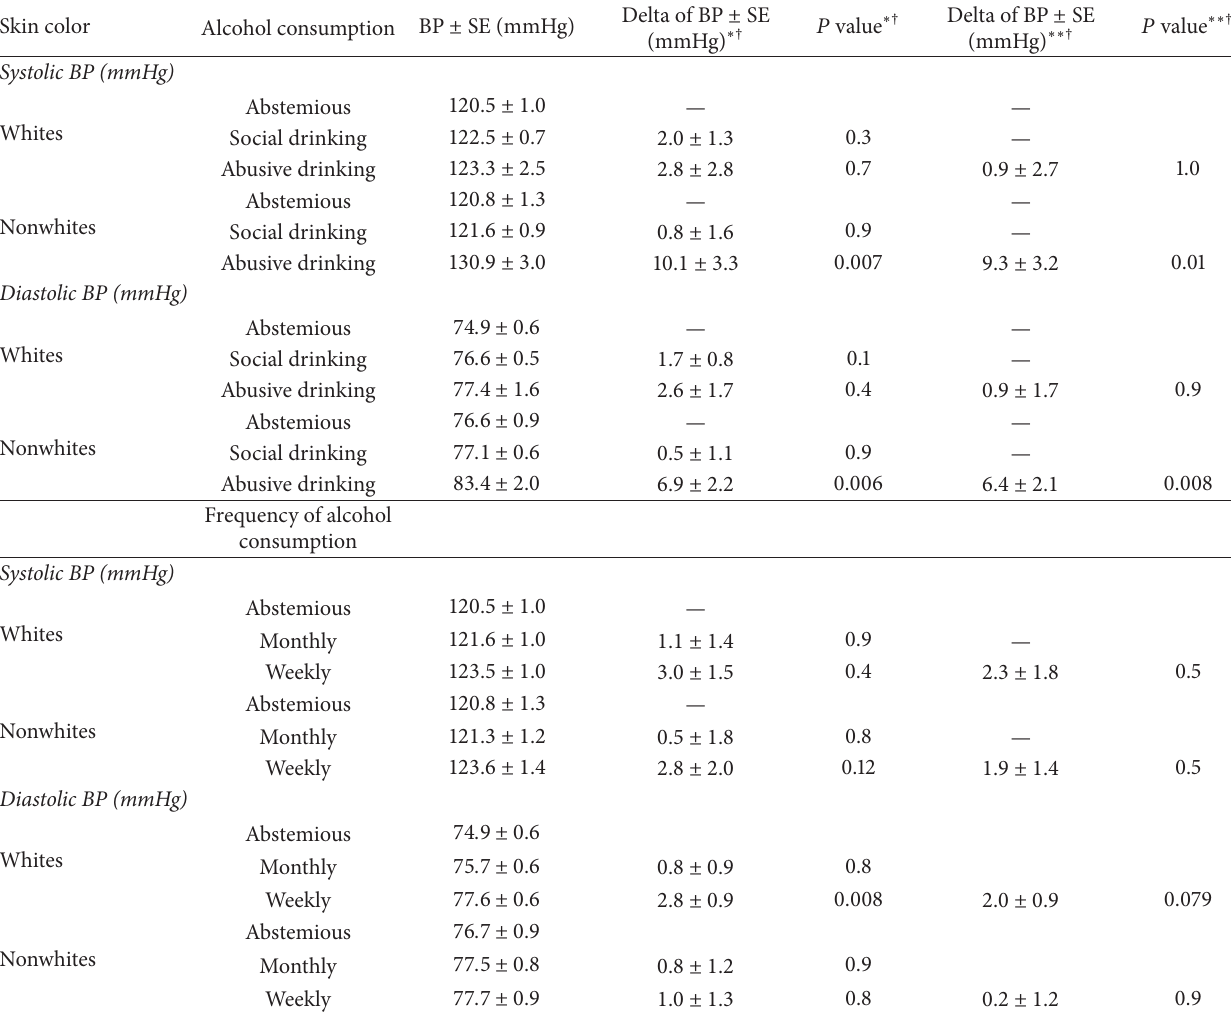
Table 4: Association of systolic and diastolic blood pressure with alcohol consumption by skin